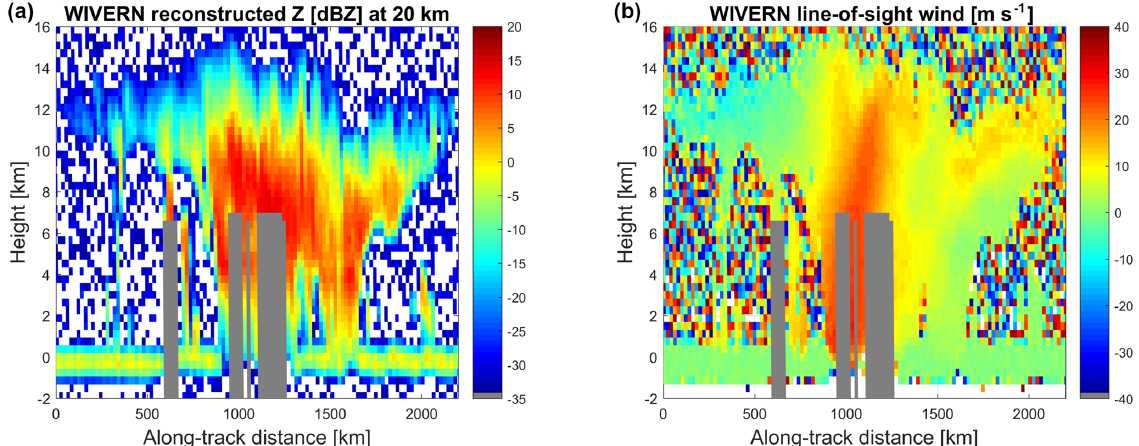
Figure 6. Reconstructed reflectivity (a) and line-of-sight Doppler velocities (b) simulated for a system with the specifics listed in Table 1 and starting from the CloudSat scene illustrated in Fig. 3. The regions shaded in grey correspond to areas in which no reconstruction of the reflectivity profile is possible due to severe attenuation or multiple scattering. Reflectivities and Doppler velocities are produced with a 20km integration length for a total of 200 H − V pairs with a T hv = 20µs (which corresponds to a Nyquist velocity of 40ms − 1